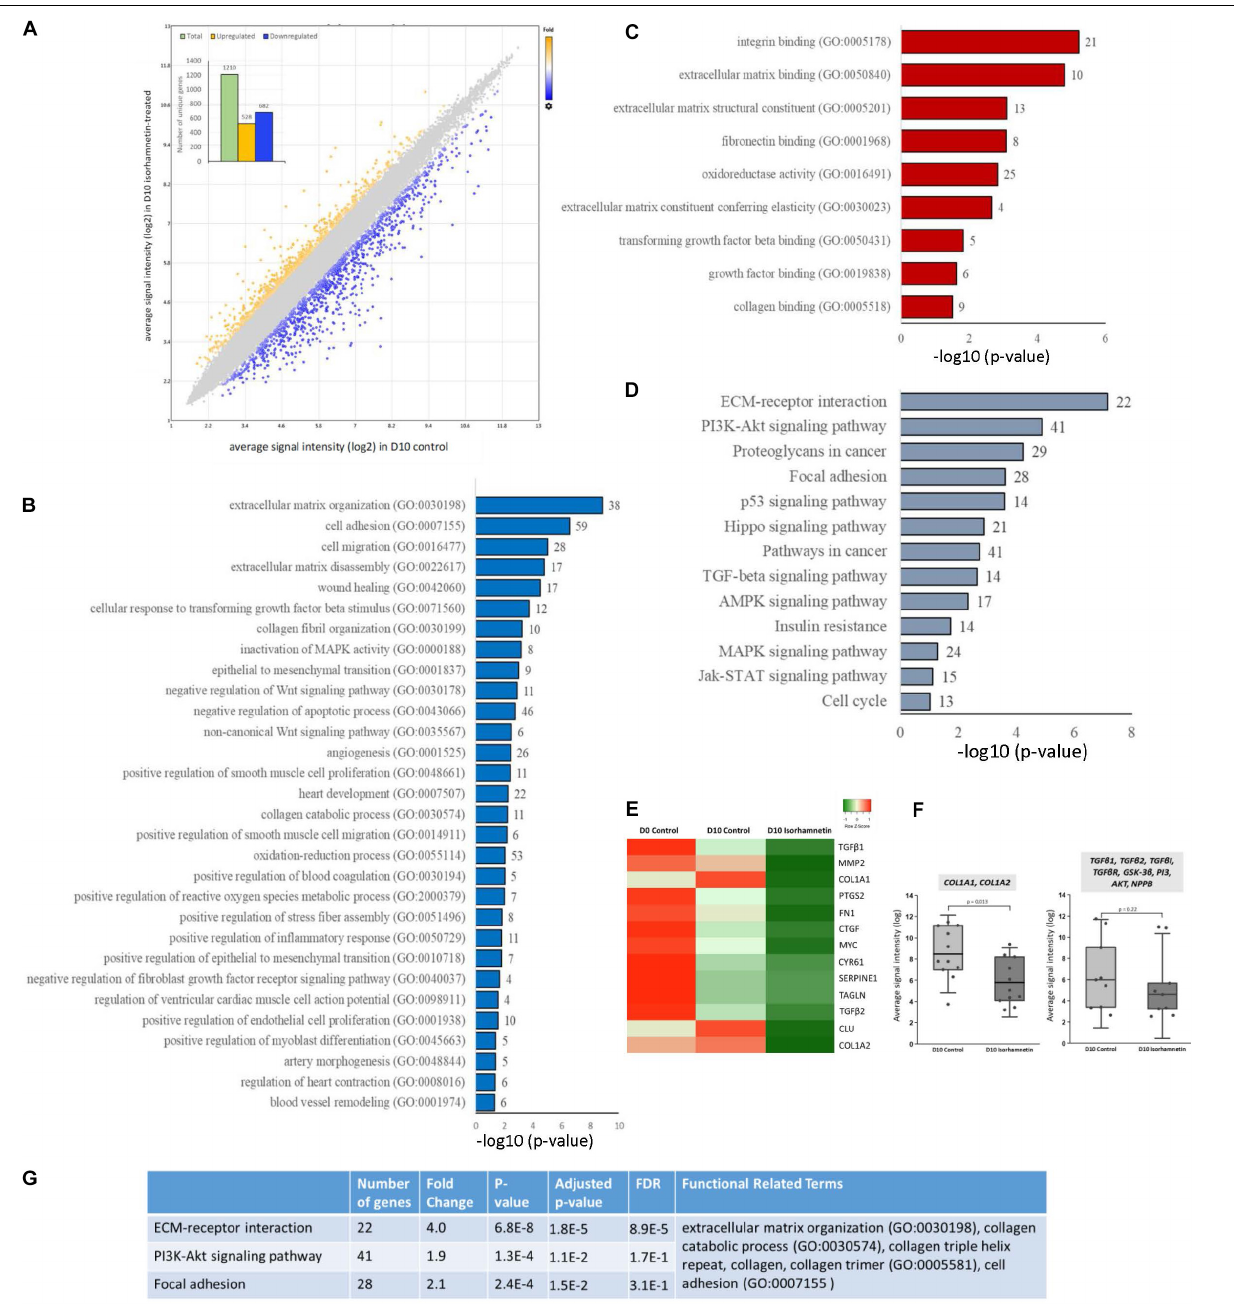
Frontiers in Cell and Developmental Biology |